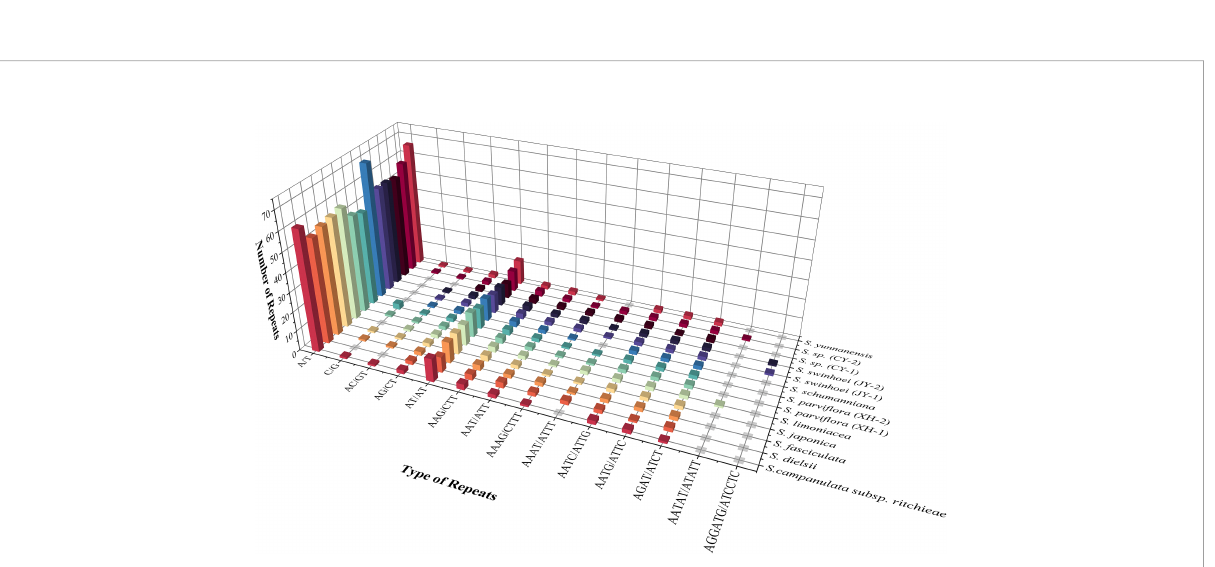
FIGURE 3 Type and number of simple sequence repeats in 13 Sabia chloroplast genomes.